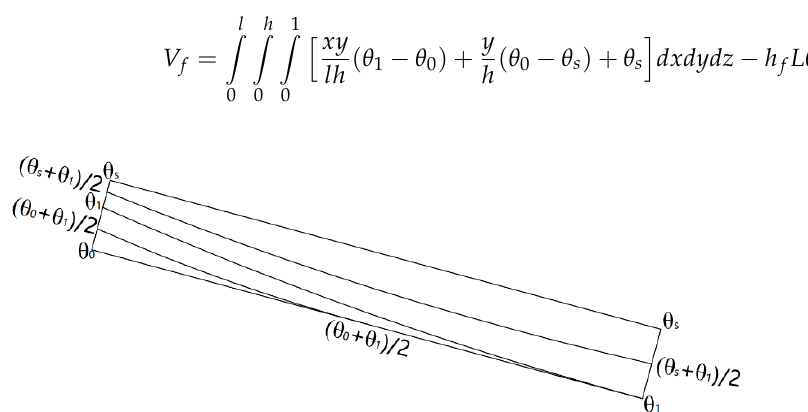
θ where, : volumetric water content at the bottom of fine-grained layer on the slope toe; t Figure 3. The scheme of water content distribution at the breakthrough time of fine-grained θ : volumetric water content at the bottom of fine-grained layer on the slope crest; h f : the c depth of fine-grained soil.